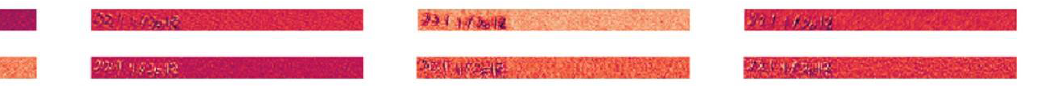
Figure 10. Example of extracted features of the first layer of ResNet-101.